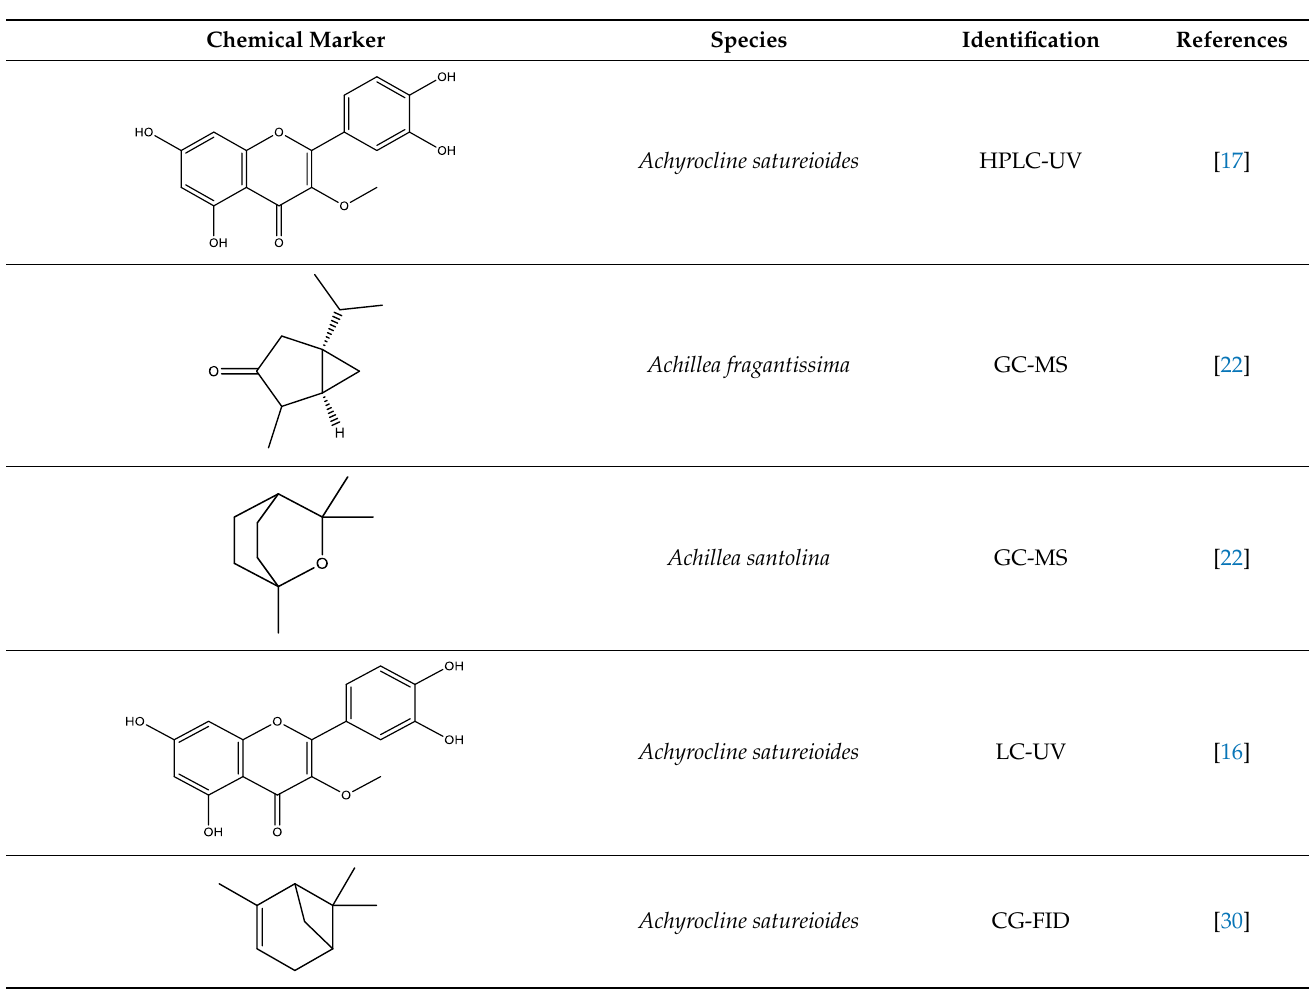
Table 3. Chemical markers of the species.